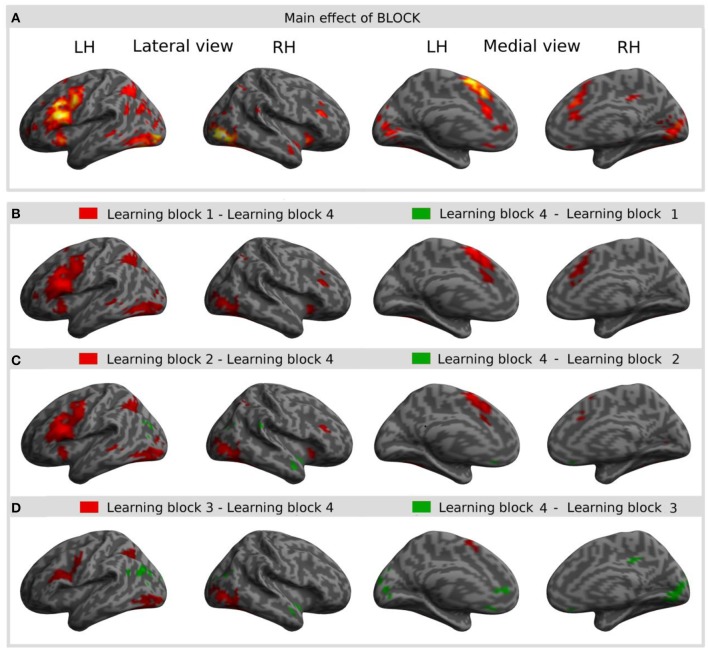
Result of the main effect of the 2 × 4 ANOVA with the factors CONDITION and BLOCK and post-hoc t-tests to test simple main effects rendered on an inflated standard MNI cortical surface. (A) Shows the main effect of the factor BLOCK (learning block 1–4). (B–D) show t-contrasts between the first (B), the second (C), and the third (D) learning block with the last learning block in order to illustrate the direction of changes over time. Colored areas represent the extent of activations, not statistical values of individual voxels.